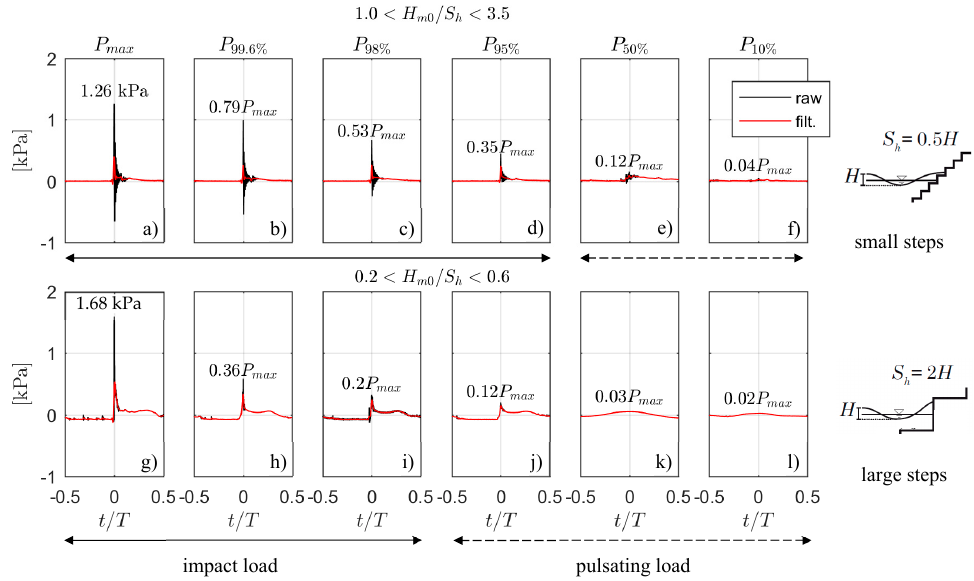
Figure 6. Comparison of pressure events with a certain probability of exceedance between small steps (( a – f ), H m 0 / S h = 1.7, test 103) and large steps (( g – l ), H m 0 / S h = 0.3, test 209).